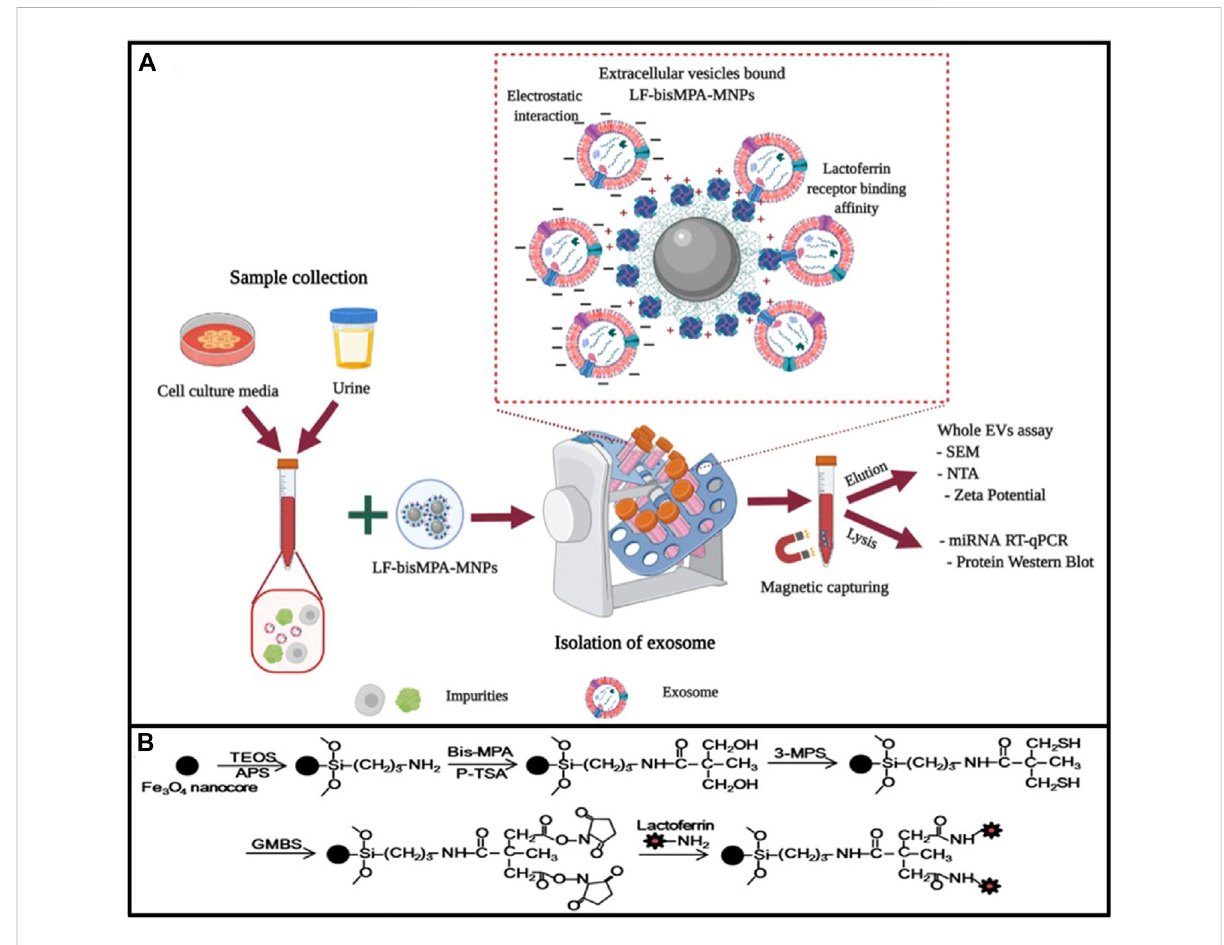
FIGURE 6 DiagrammaticelucidationofEVisolationbyLF-bis-MPA-MNPs. (A)